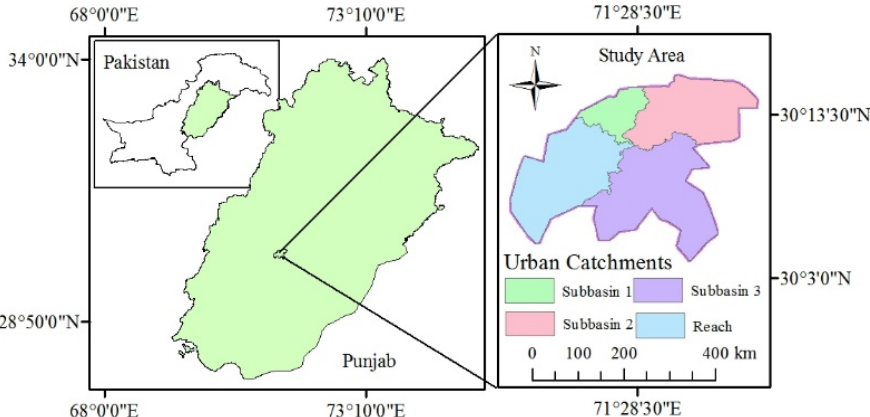
Figure 1. Map of the research area, including sub-catchments.